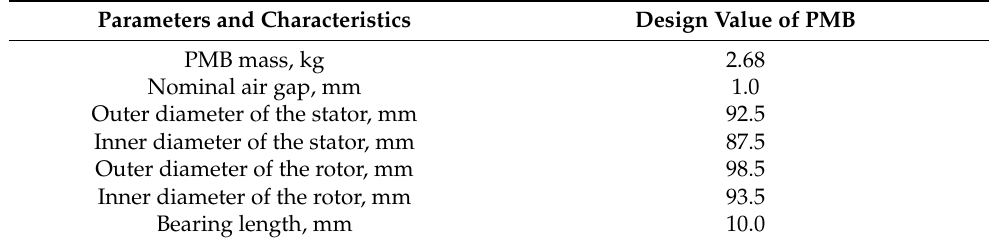
Figure 3. PMB scheme. ( a ) The structure of the PMB. ( b ) Bearing configuration schematic. Table 1. Design parameters of the PMB.